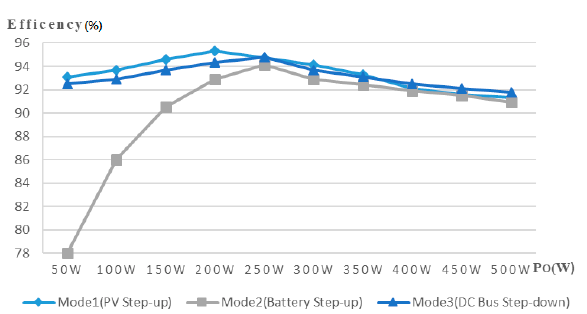
Figure 15. Efficiency curve of proposed three-port bidirectional converter.